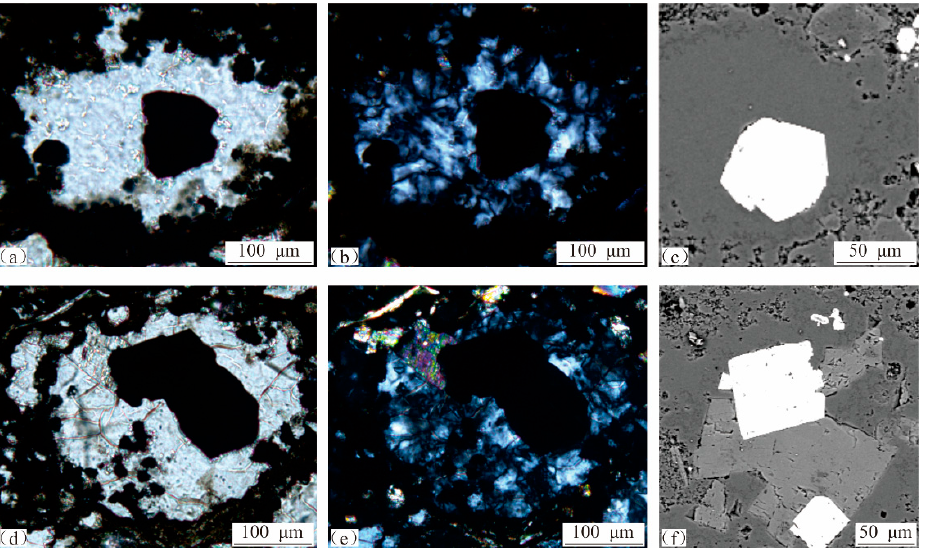
Figure 7. Typical images showing radiolarian siliceous shell cavities filled with pyrite. ( a , b ) Cavity filled with pyrite. a. Plain light. b. Perpendicular light . ( c ) Cavity filled with pyrite. ( d , e ) Cavity filled with pyrite, dissolved pores within calcite. d. Plain light. e. Perpendicular light. ( f ) Pyrite and calcite in cavity, pyrite in dissolved pores within